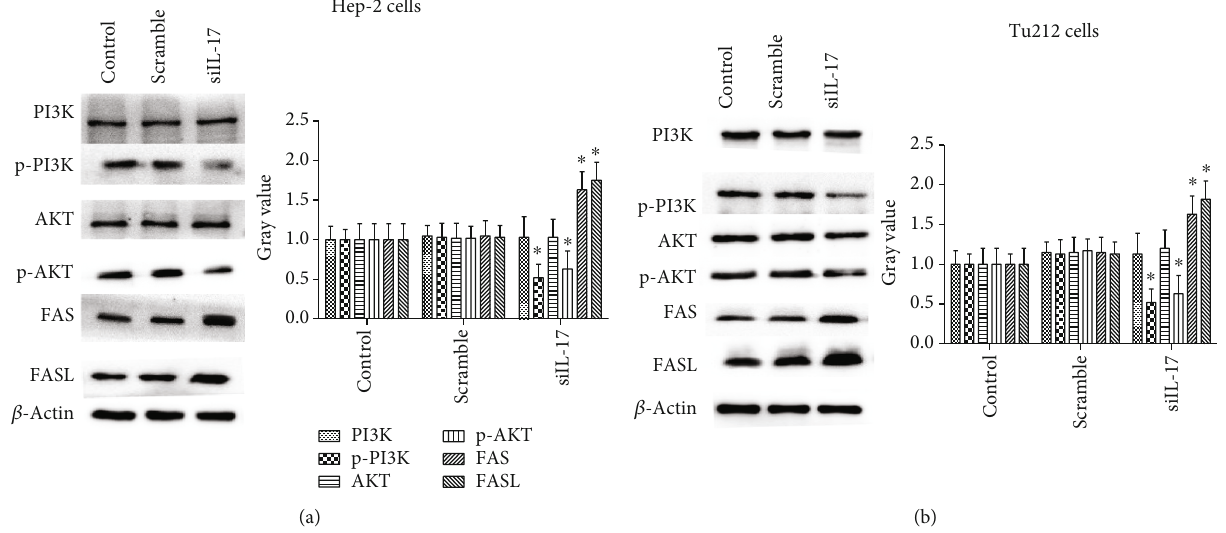
Figure 7: E ff ects of silencing LC cell IL-17 gene expression on the activation of PI3K/AKT/FAS/FASL pathways in the LC cell lines. (a) Downregulation of the IL-17 gene expression by siRNA causes expression of FAS and FASL to increase activation in Hep-2 cells. (b) Downregulation of the IL-17 gene expression by siRNA causes expression of FAS and FASL to increase in Tu212 cells. One representative experiment of the three independent experiments is demonstrated. ∗ P < 0 : 01 compared with the control